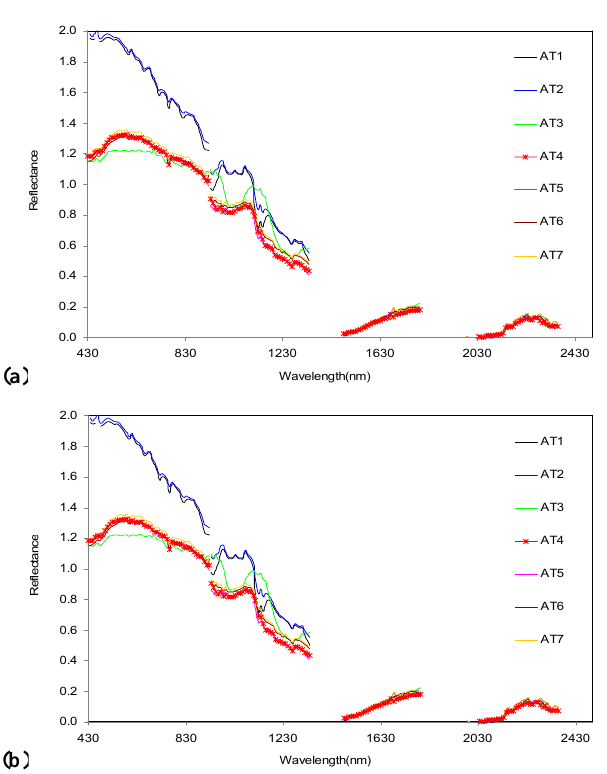
Fig. 4. The atmospheric corrected snow spectra from Hyperion im- age using different atmospheric and aerosol models for nearby area of (a) Station-1 of Lower Himalaya and (b) Station-2 of Middle Himalaya. The different legends are explained in Table 2.